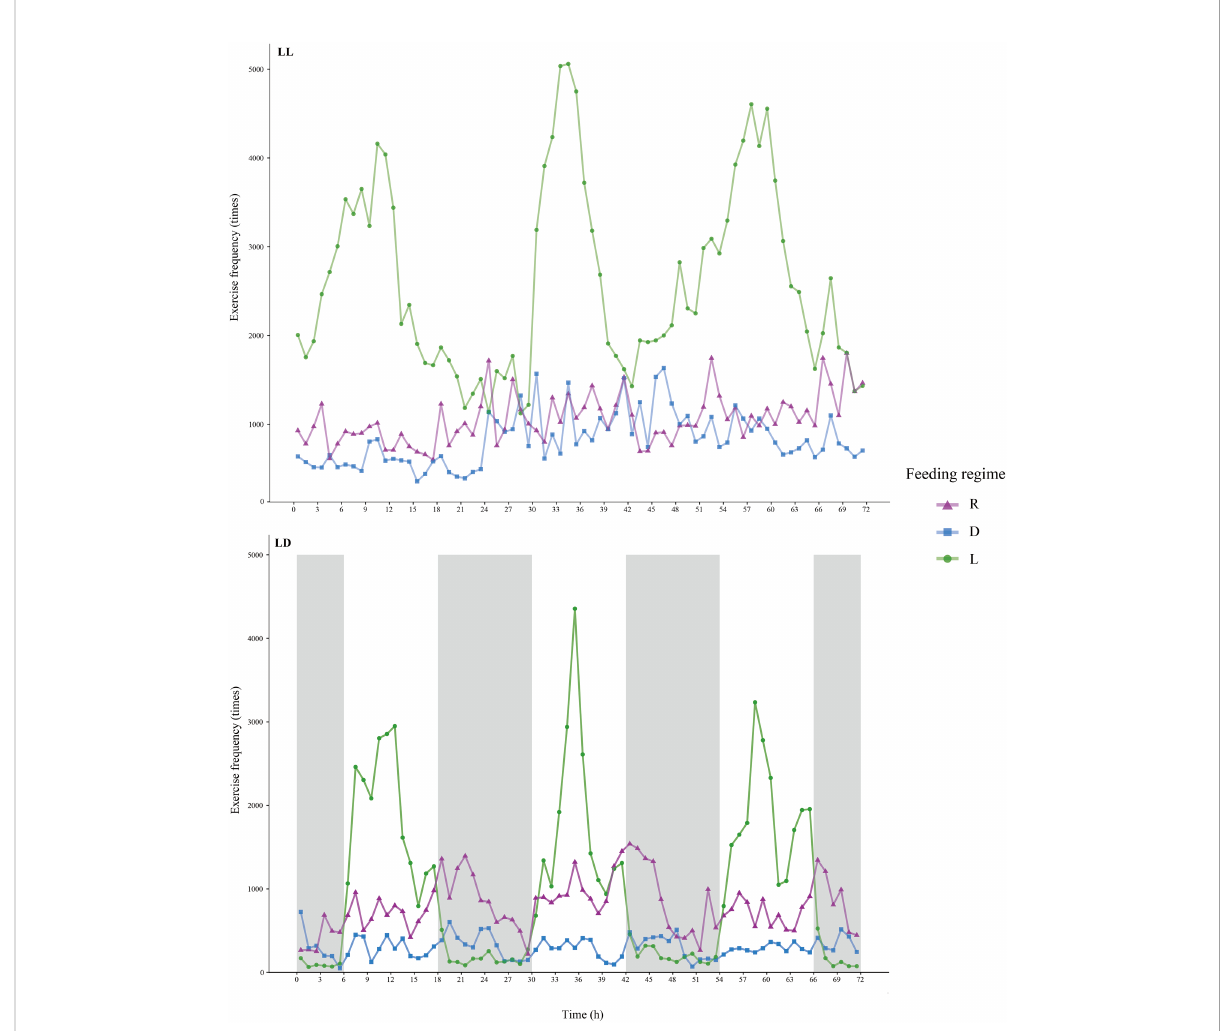
FIGURE 2 Exercise frequency of juvenile Oncorhynchus mykiss under different experimental treatment. The bright bars indicate the light period and the dark bars indicate the dark